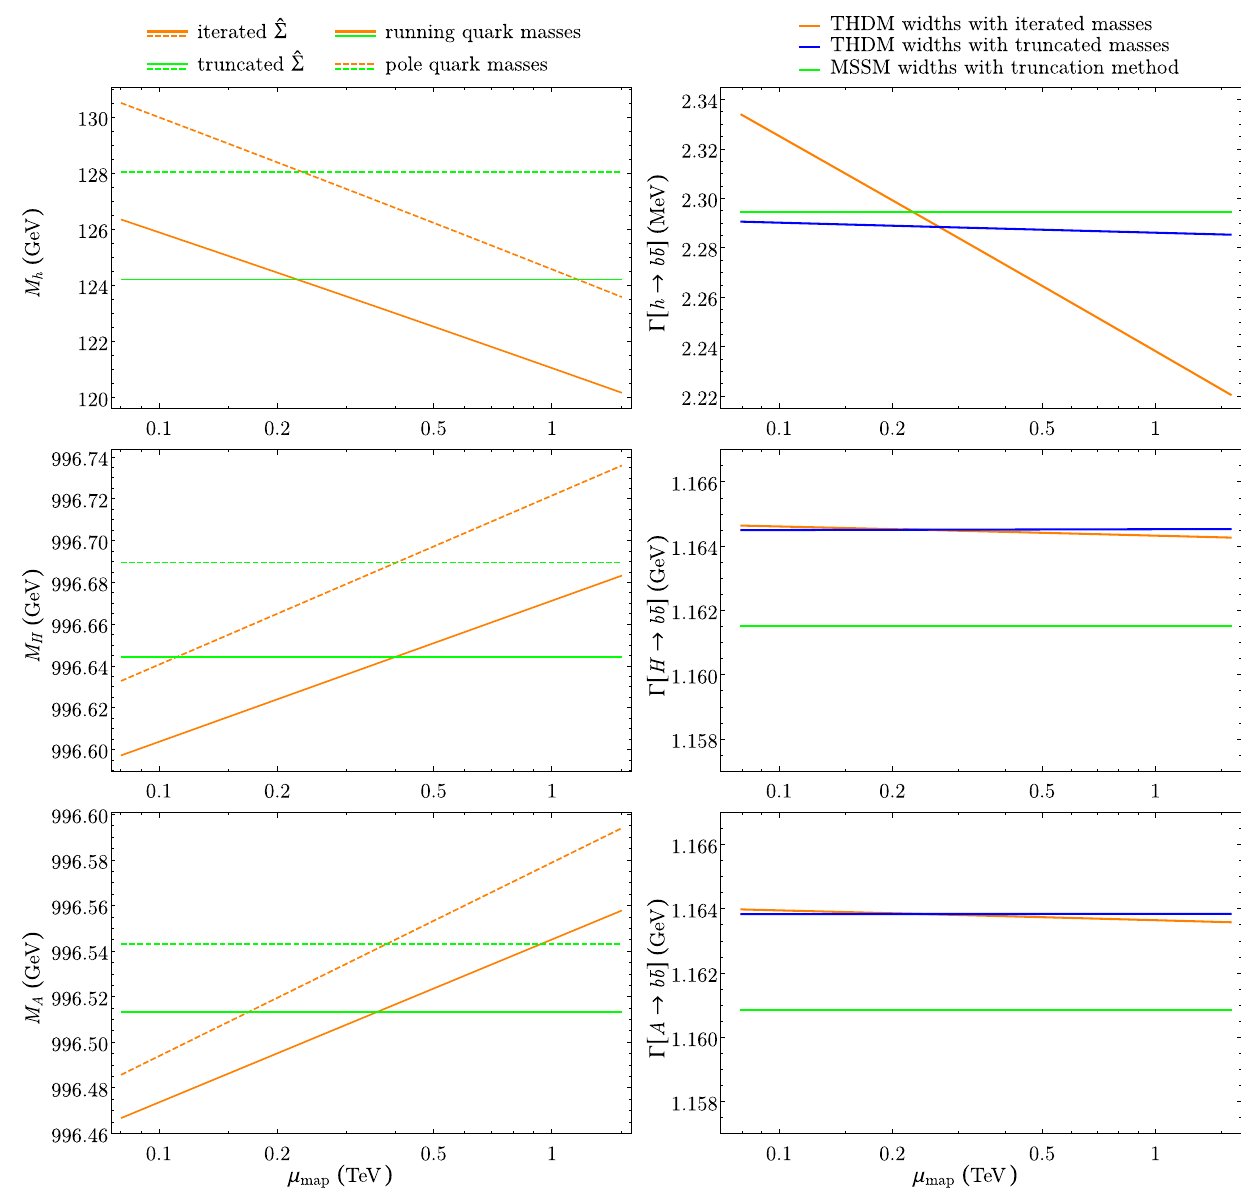
Fig. 3 Left: The scale dependence associated with the mapping pro- cedure is shown for the neutral Higgs masses derived by the recursive condition of Eq.(5) with ξ -independent self-energies in a THDM for the scenario of Fig.1 (orange curves). The mapping scale is varied between M W and 1 . 5TeV. The masses obtained in the MSSM from the expansion of Eq.(4) (‘truncation’ method) are shown in green for ref- erence. The solid and dashed curves employ different definitions of the fermion masses, offering an estimate of the magnitude of the O corrections. Right: The scale dependence associated with the match- ing procedure is shown for the Higgs decays into bottom quarks at the kinematic Higgs masses given by the loop-corrected value from the